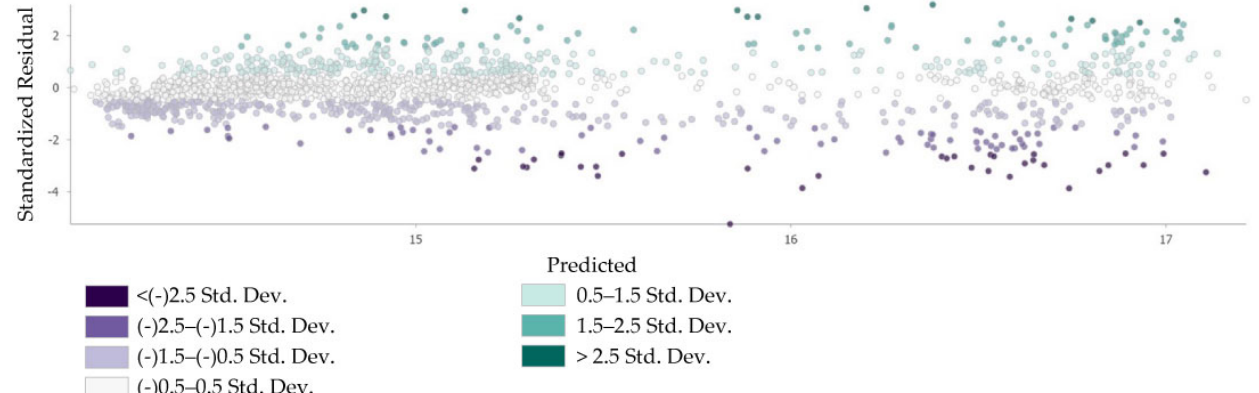
Figure 8. Standardized residuals vs predicted values plot for the GWR model.